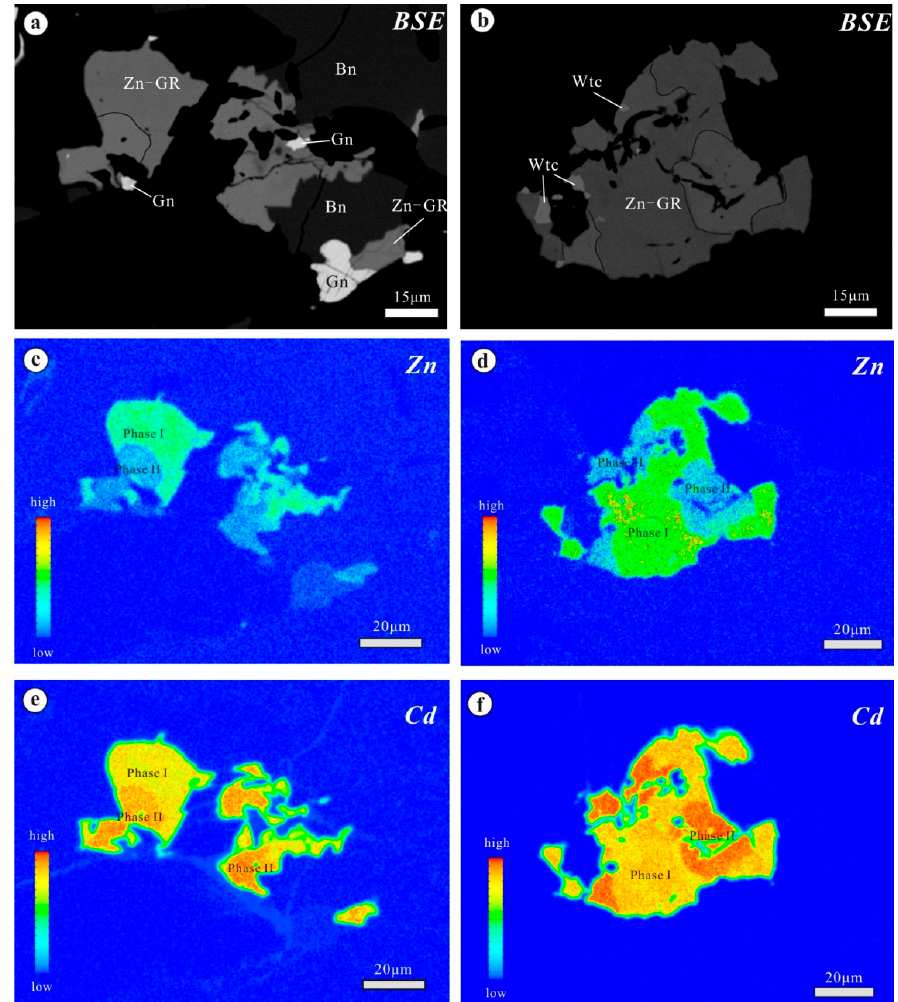
Figure 7. ( a , b ) Back-scattered electron images (BSE) of zincian greenockite; ( c , e ) X-ray element-distribution maps for Zn and Cd of zincian greenockite for the area shown in Figure 6d; ( d , f ) X-ray element-distribution maps for Zn and Cd of zincian greenockite for the area of Figure 6c. The two grains indicate that the distribution of Zn and Cd is inhomogeneous and demonstrate an inverse correlation between Zn and Cd in zincian greenockite. Two phases (I and II) are evident and discussed in the text. Mineral abbreviations: Zn-GR = zincian greenockite, Bn = bornite, Wtc = wittichenite, Gn = galena.